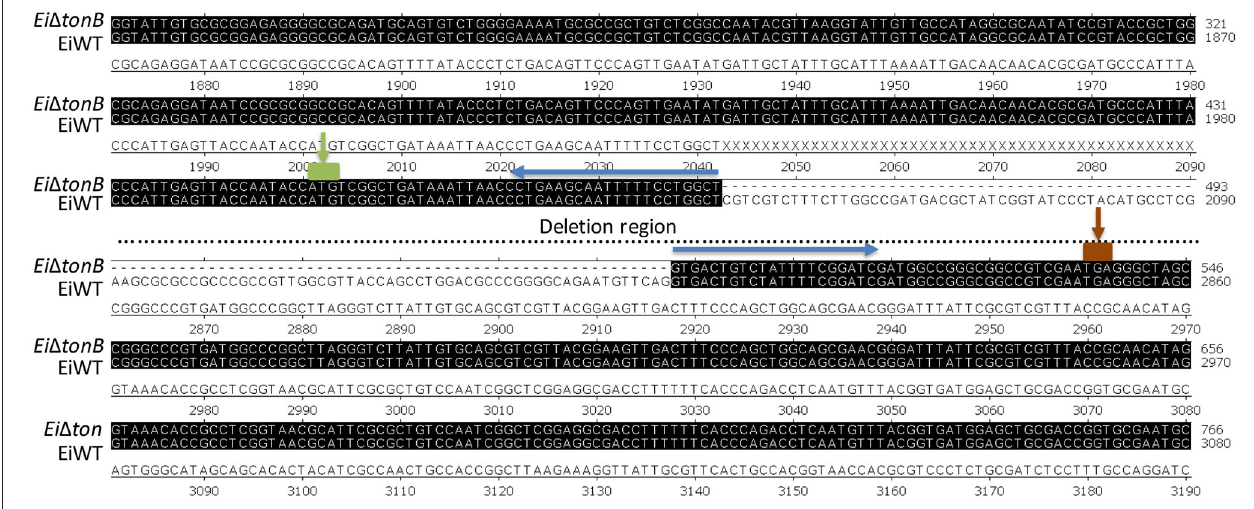
FIGURE 2 | Nucleotide sequence alignment of tonB genes in E. ictaluri and Ei 1 tonB . The matching region is shadowed in black. “---“ indicates deleted gene region in Ei 1 tonB . For clarity, the deleted gene region was cropped, which is shown by “…”. The green box and arrow indicate start codon, and the red box and arrow indicate stop codon of the tonB gene.